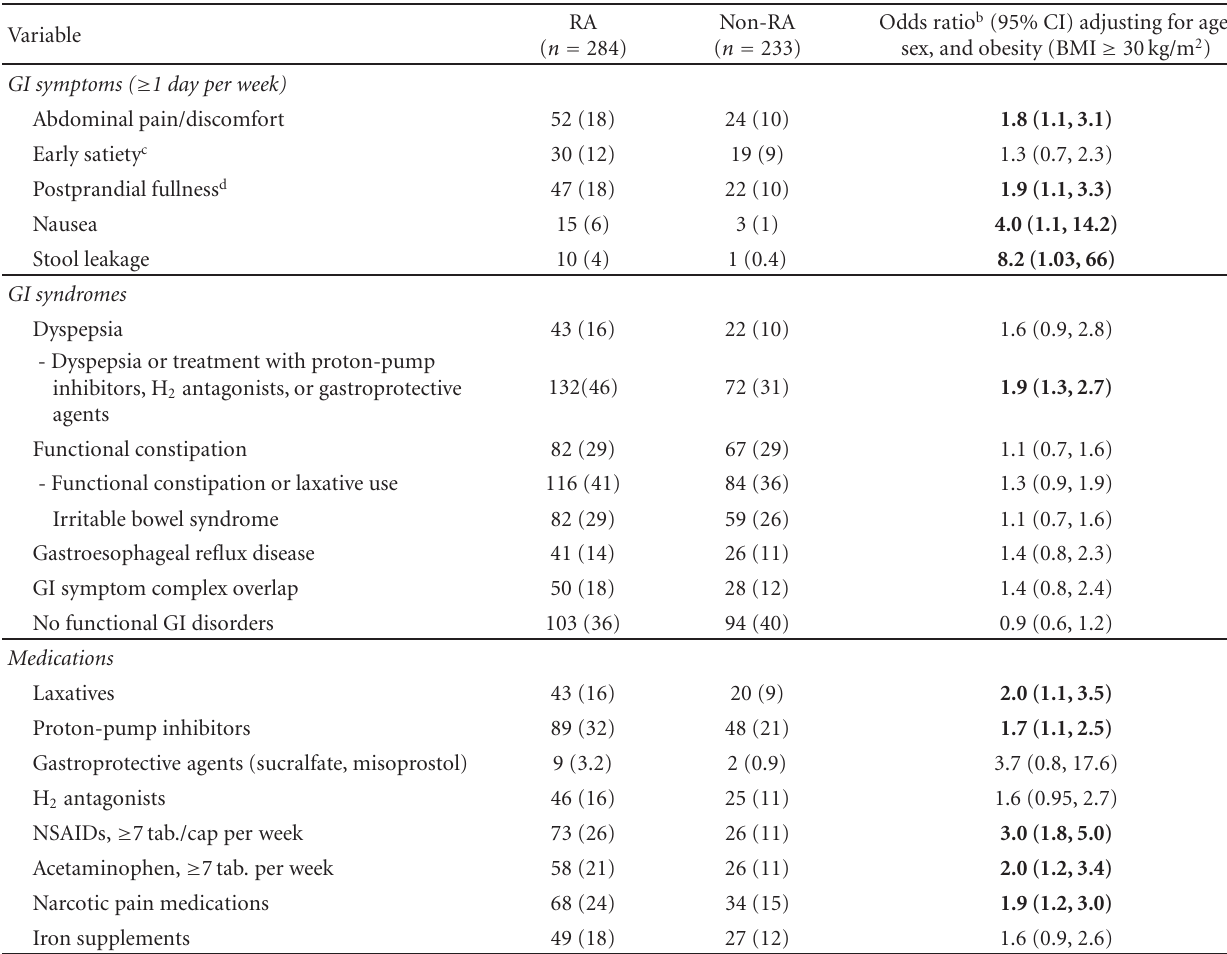
Table 3: Gastrointestinal complaints and medications in RA and non-RA cohorts a